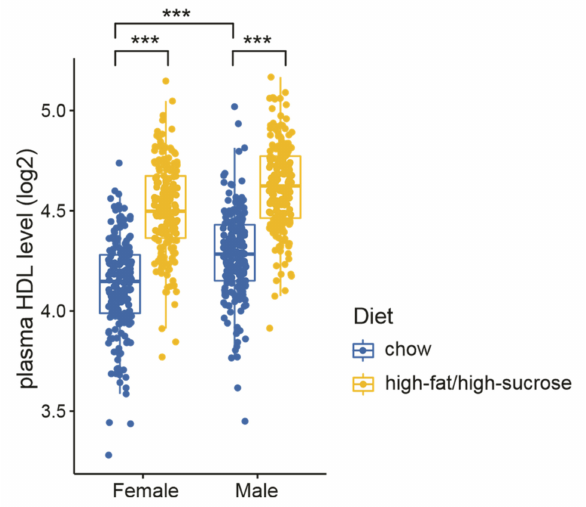
Figure 1. Influence of diet and sex on plasma HDL levels in a diversity outbred (DO) mouse cohort. Plasma HDLs were measured for 835 mice at 8 weeks of age. Statistical significance between different groups was determined by two-way ANOVA. ***, p <